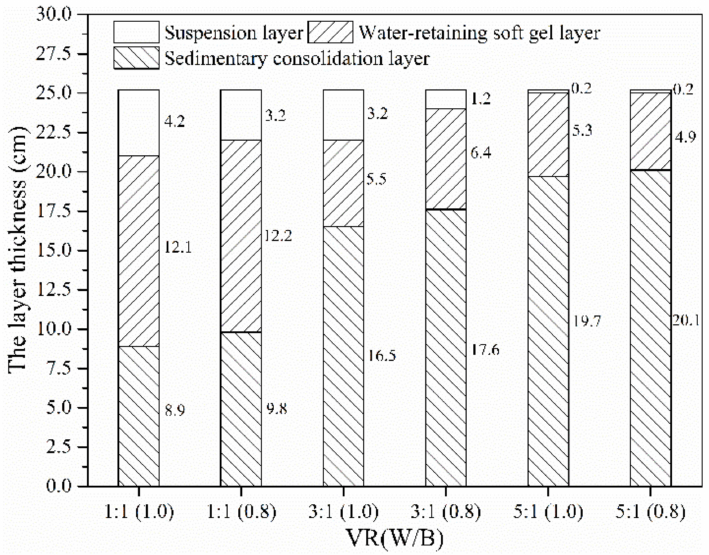
Figure 5. Deposition thicknesses of different layers with varying mixing proportions of